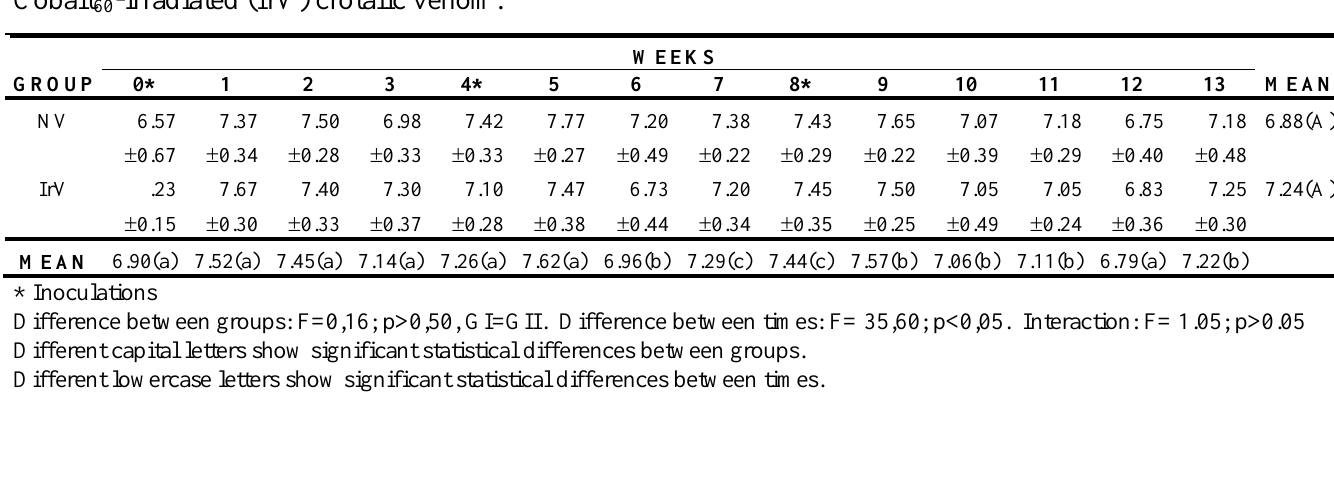
* Inoculations Difference between groups: F=1,78; p>0,10, GI=GII. Difference between times: F= 5,64; p<0,05. Interaction: F= 1.40; p>0.05 Different capital letters show significant statistical differences between groups. Different lowercase letters show significant statistical differences between times. Table 6. Means and standard deviation of plasma protein (g/dL) in sheep (n=12) inoculated at days zero, 30, and 60 with natural (NV) and Cobalt -irradiated (IrV) crotalic venom. 60